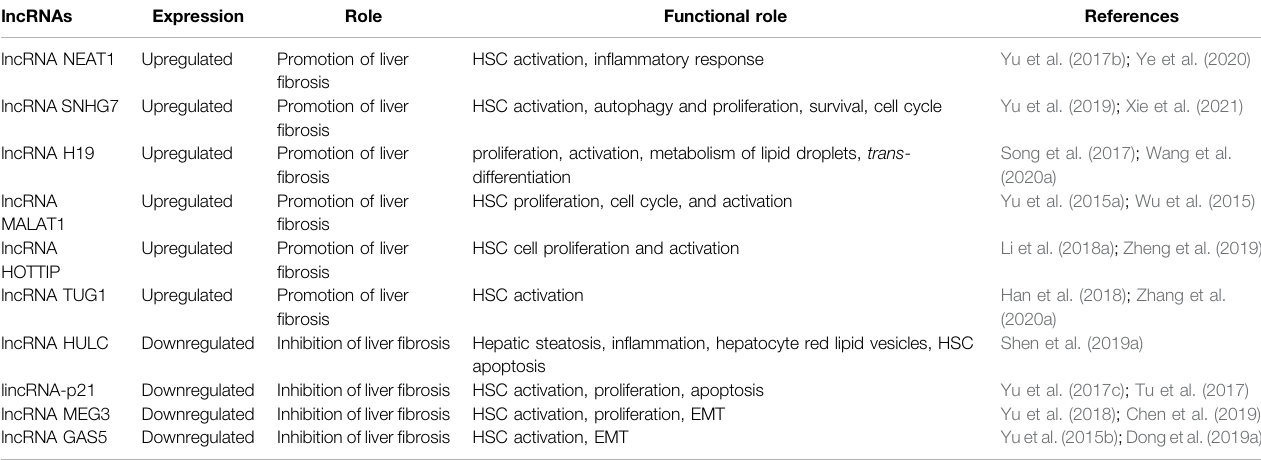
TABLE 1 | The expression of lncRNA in liver fi